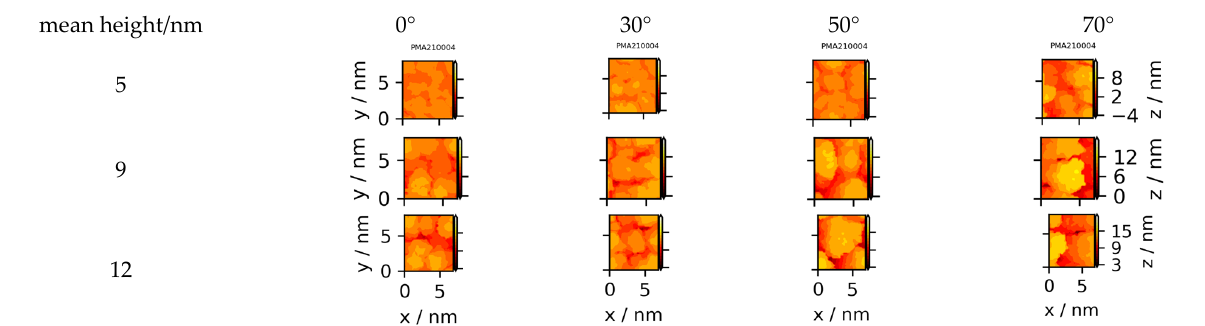
Figure 5. Images of the surface morphology for a substrate area of 7 × 8 nm 2 and different mean heights. The scale is shifted for different heights, but its range is kept the same to make all images comparable.